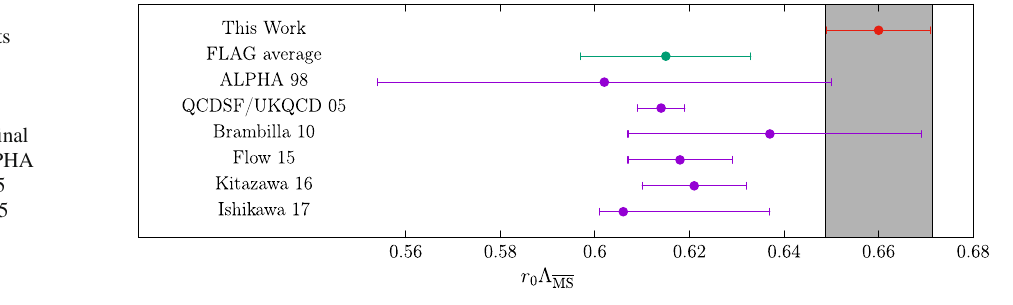
), give a small SF